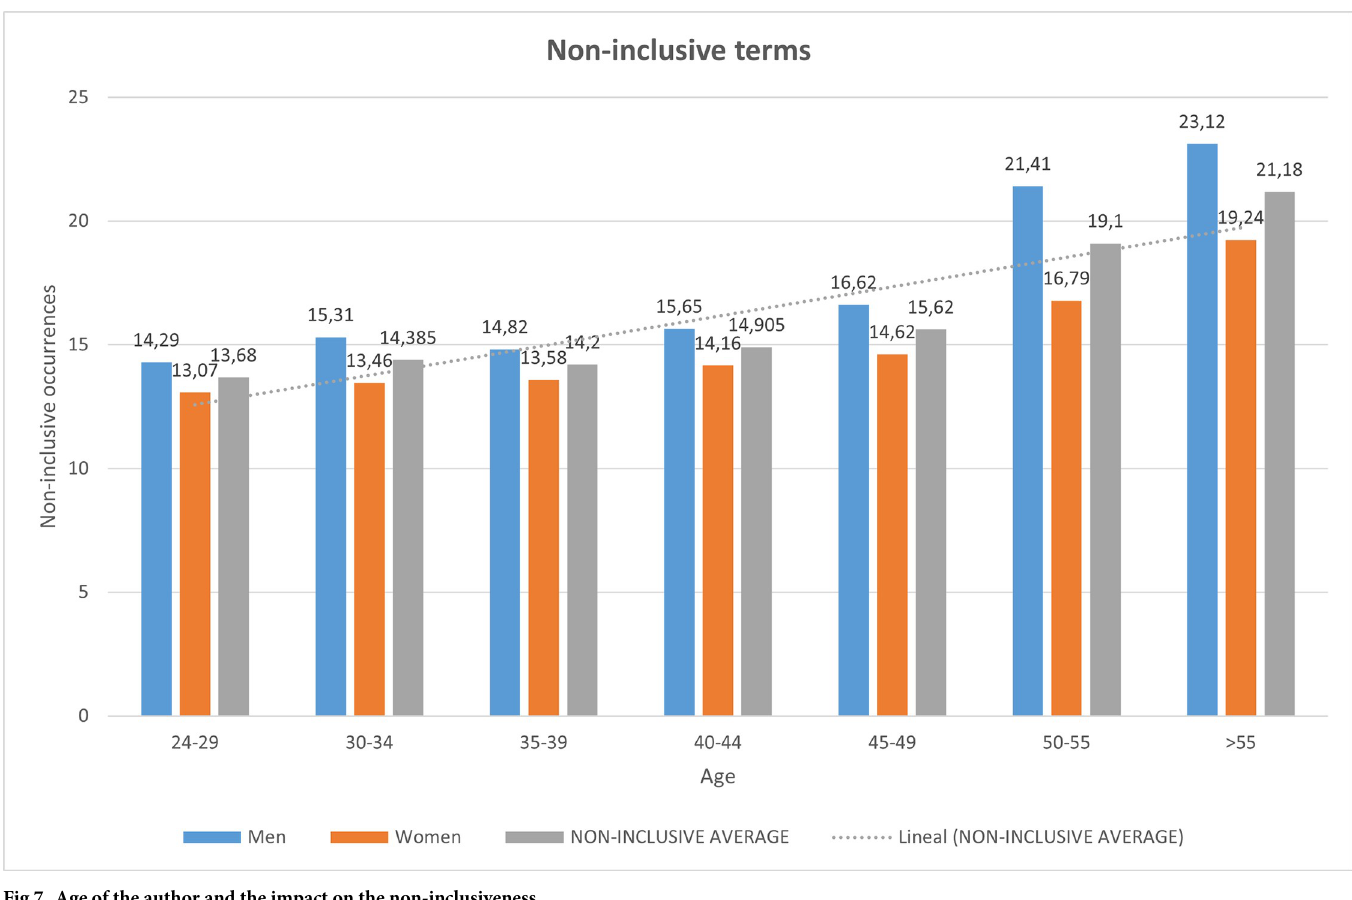
Fig 7. Age of the author and the impact on the non-inclusiveness.